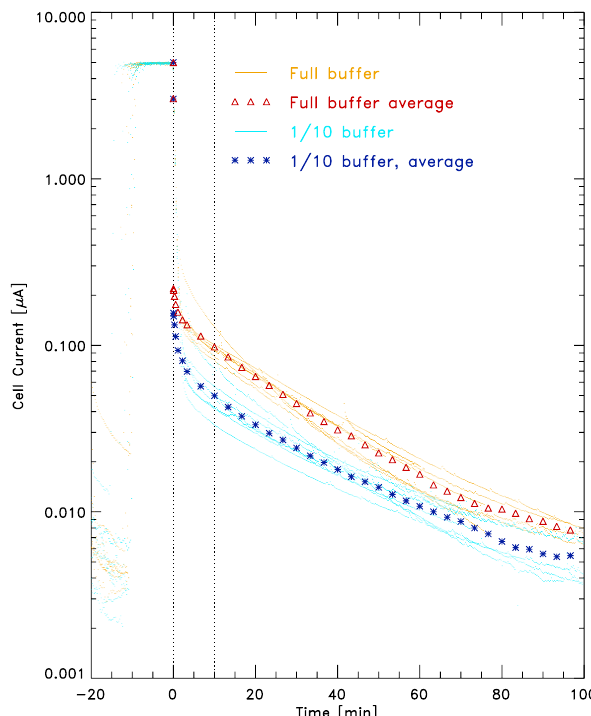
Fig. 2. Cell current with purified air before, during, and after the 5µA cell conditioning. One second data are shown for each run (thin dotted lines) as well as one minute averages over all runs using the same solution type ( 1 for full average and ∗ for 1/10th buffer